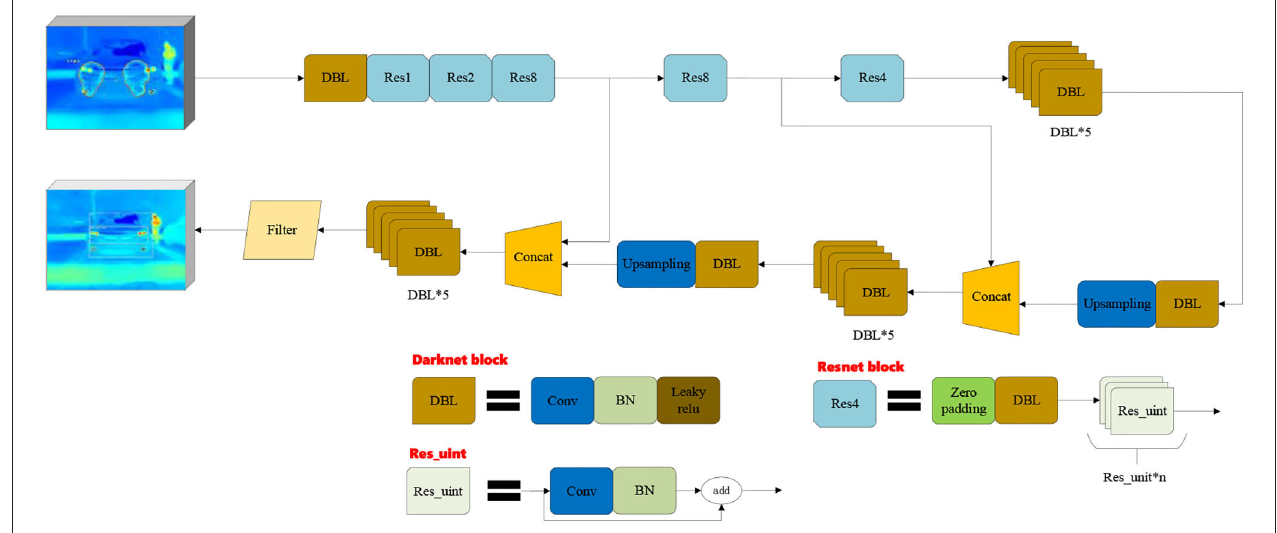
FIGURE 4 | The YOLOv3 with adding a filter (YOLOv3-Filter).